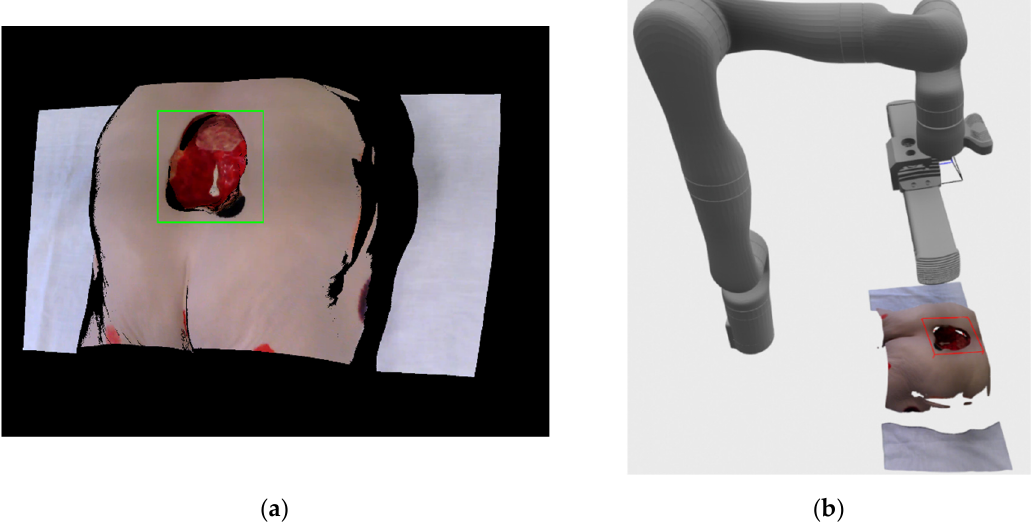
Figure 6. ( a ) Result of the wound detection on the registered RGB/Phoxi image; ( b ) recorded color point cloud with generated bounding box in regard to the position of the robot arm.